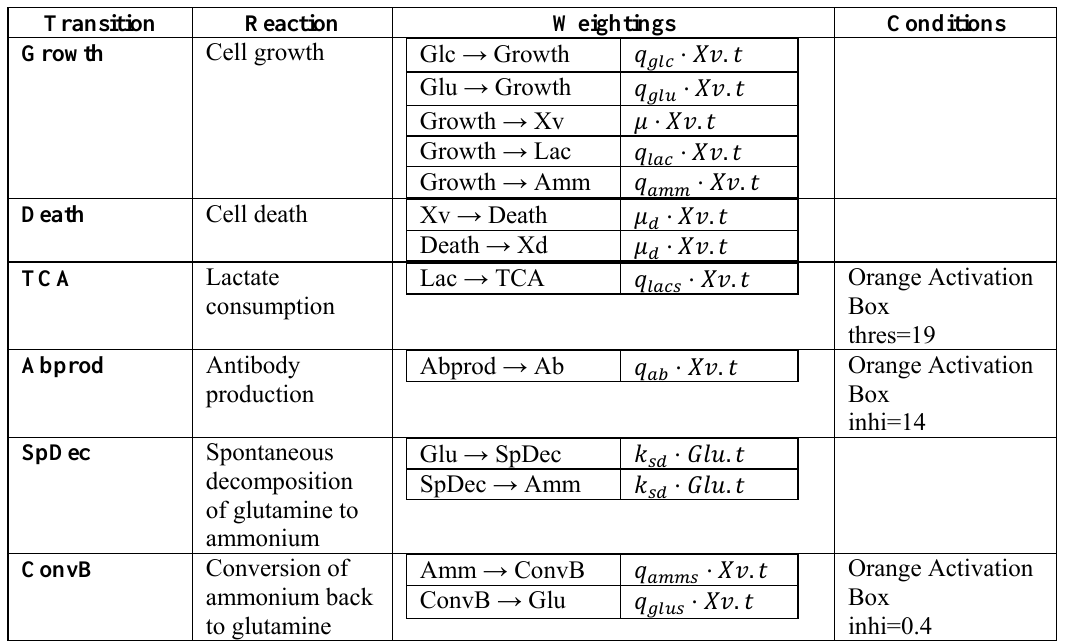
Transitions of the CHO-model in Figure 25, the corresponding reactions and the edge weighting functions (Eq. 1 - Eq. 4, Eq. 11 - Eq.